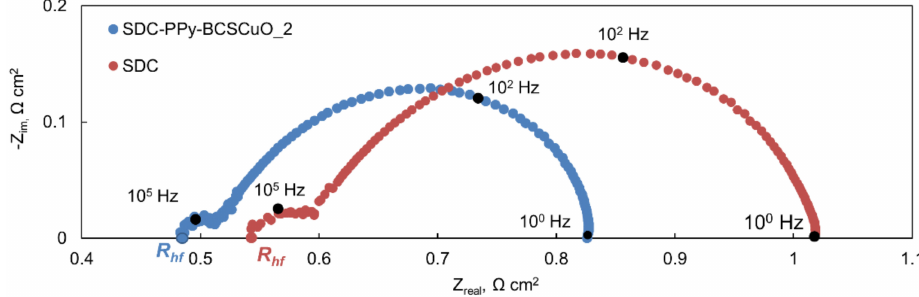
Figure 9. Examples of the spectra obtained at 700 °C under open-circuit conditions for the SDC and SDC-PPy-BCSCuO_2 samples.